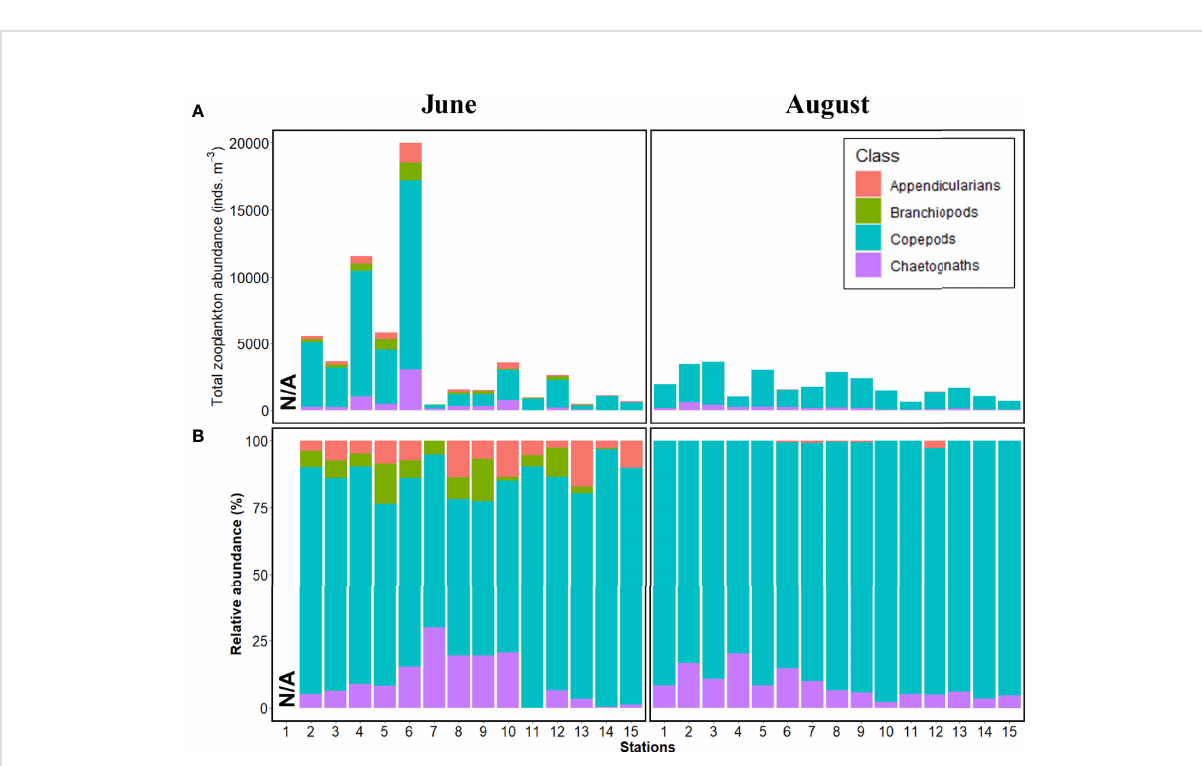
FIGURE 3 Zooplankton abundance patterns in Yeosu Bay in June (left) and August (right). (A) Total zooplankton abundance (inds. m -3 ). (B) Stacked percentage (%) of zooplankton abundance. N/A represents non-sampled